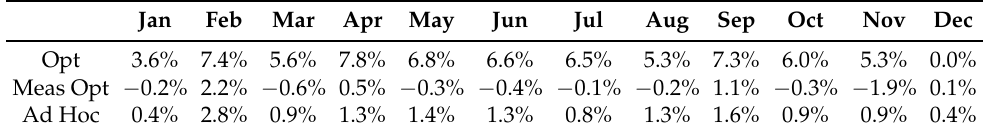
Table 14. Monthly PV and Wind self-consumption improvement for a building cluster.